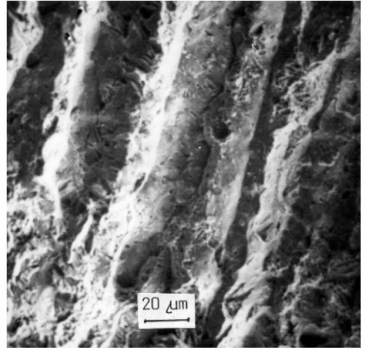
Figure 13. Decohesive failure at the dendrite borders.